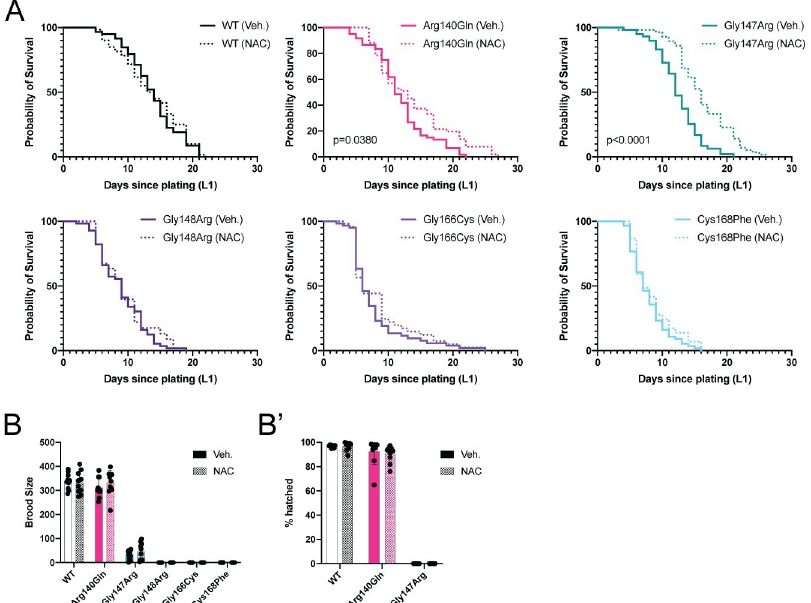
Fig 6. Antioxidant treatment partially suppresses the nfu-1 phenotype. (A) Kaplan-Meier survival curve of nfu-1 mutants with either Veh. (H 2 O) or NAC treatment (n = 58–60). Detailed statistical analysis presented in Table 3. (B-B”) Fecundity assays following treatment with Veh. (H 2 O) or NAC (n = 9–10). (B) Total brood size. (B’) Embryonic viability. No statistical differences between treated and untreated. B-B’: Analysis by parallel two-tailed Student’s T-test with Holm-Sidak correction for multiple comparisons. Veh.: Vehicle; NAC: N-acetyl-L-cysteine.